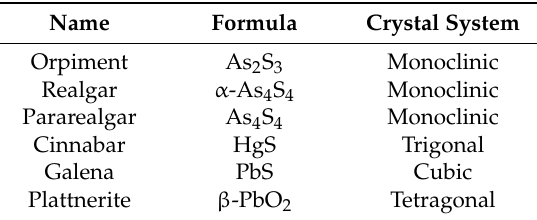
Table 4. Yellow, orange, red and black mineral